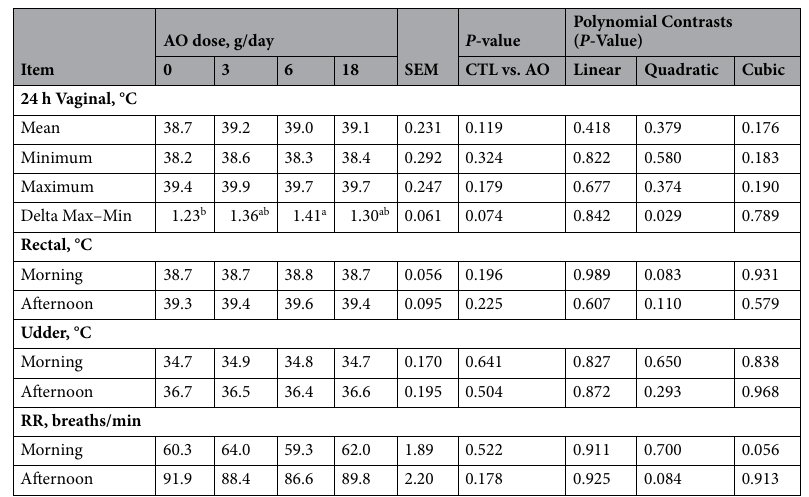
Table 1. Vaginal, rectal, and skin udder temperature and respiration rate (RR) of lactating Holstein cows fed an Aspergillus oryzae (AO) postbiotic under heat stress conditions (least squares means ± SEM). CTL control treatment. a,b Superscripts denote AO dose differences among means (0.05 < P ≤ 0.10). CTL vs. AO denotes contrast between CTL and AO postbiotic.